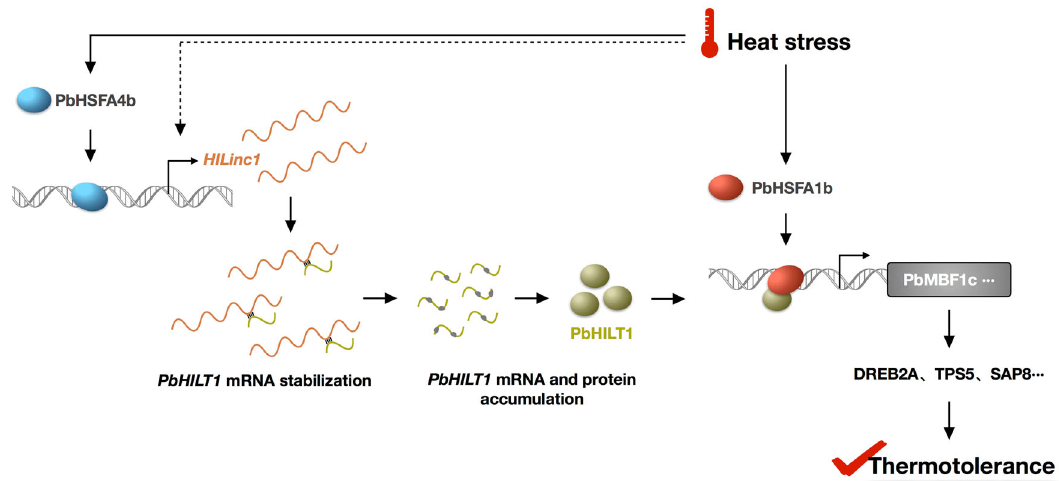
Fig. 7 A proposed model showing the role of HILinc1 and PbHILT1 in the heat response and thermotolerance regulation in pear. At high temperatures, HILinc1 is induced by PbHSFA4b and stabilizes PbHILT1 transcripts by forming an RNA duplex. PbHILT1 interacts with PbHSFA1b and enhances its transcriptional activity, resulting in the upregulation of downstream HSR genes (such as PbMBF1c ) and the improvement of